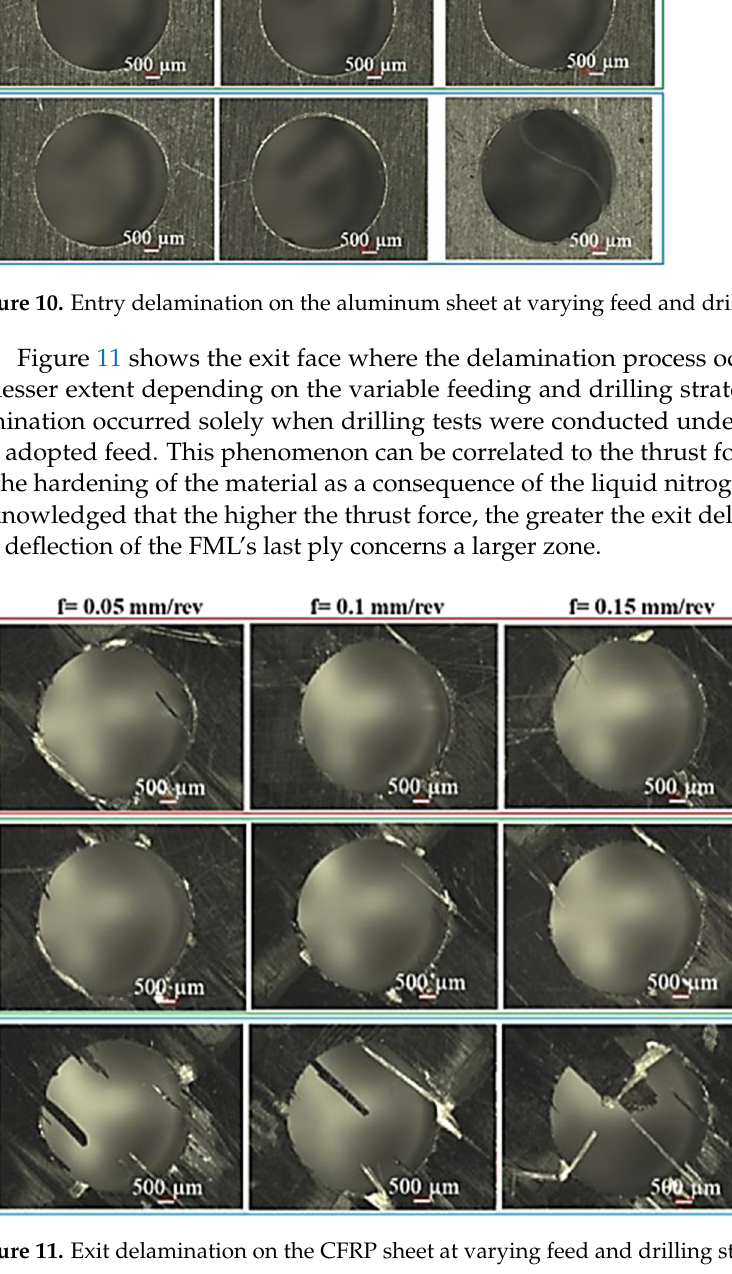
Figure 11. Exit delamination on the CFRP sheet at varying feed and drilling strategies [73].